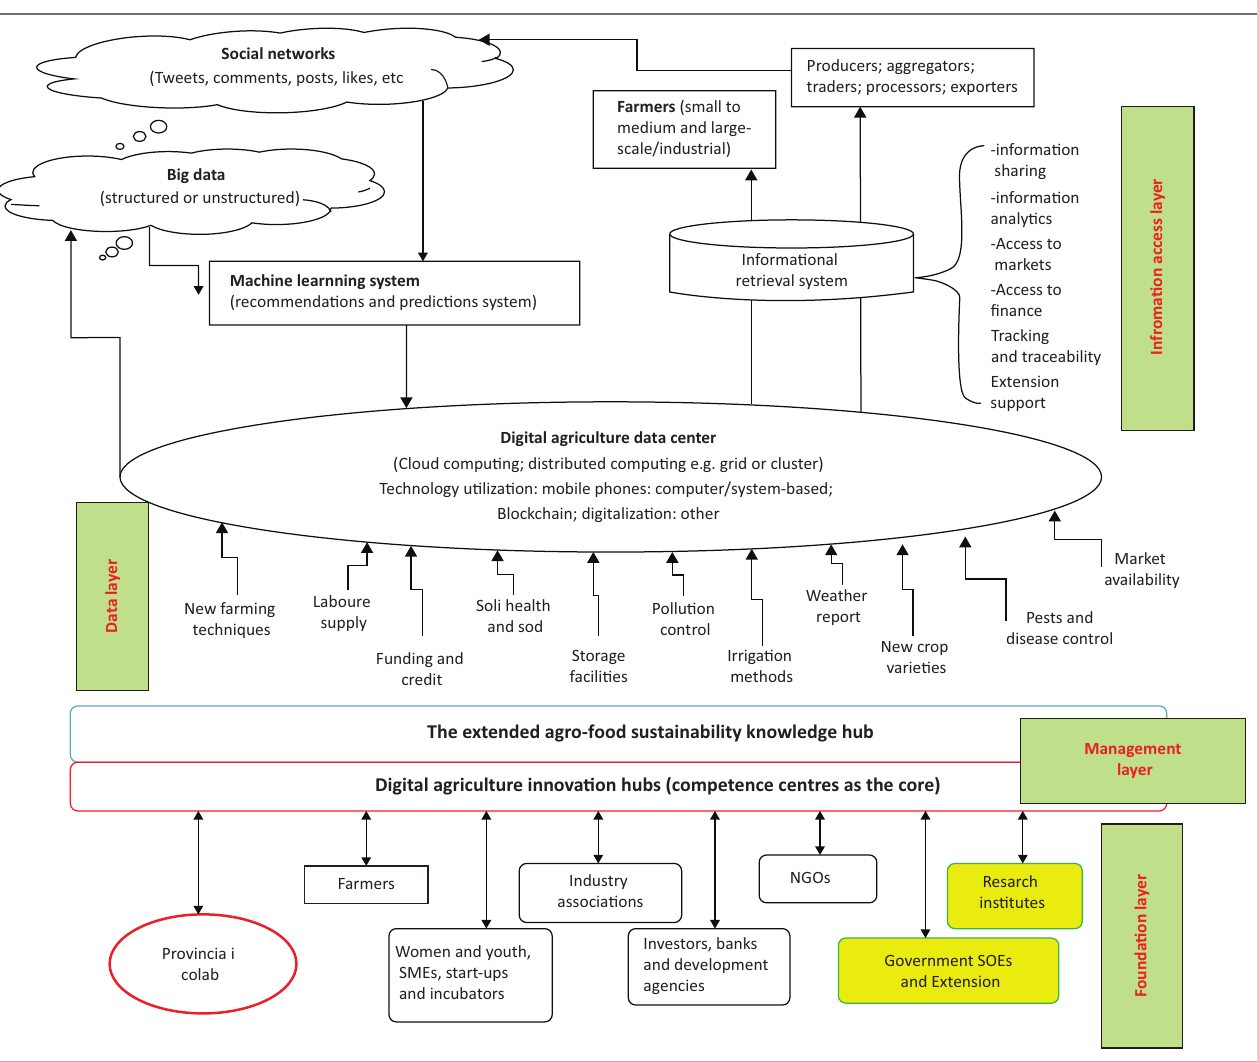
FIGURE 12: Proposed framework for the adoption of a digital agriculture value